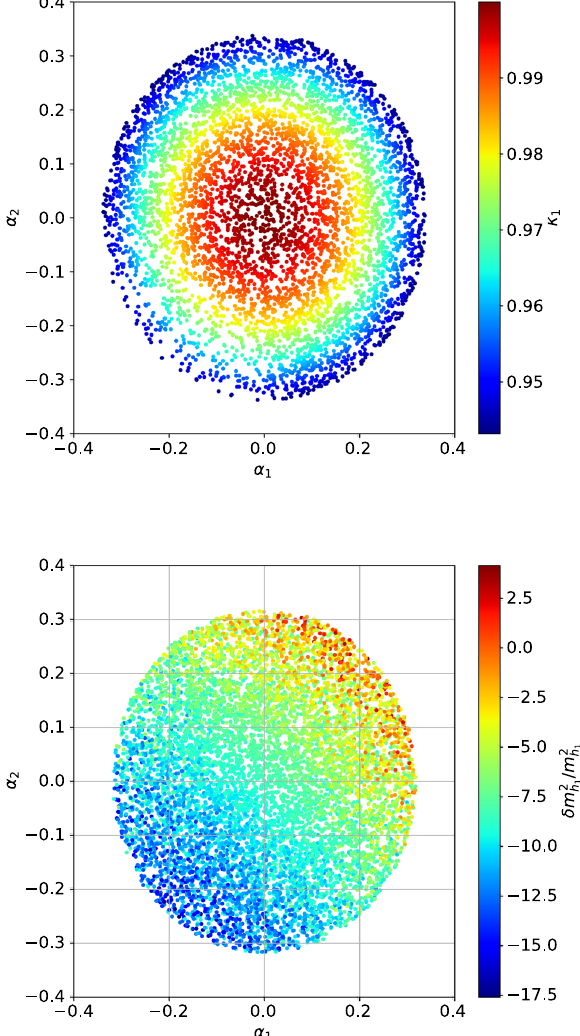
/ m 2 radiativecor- h 1 h 1